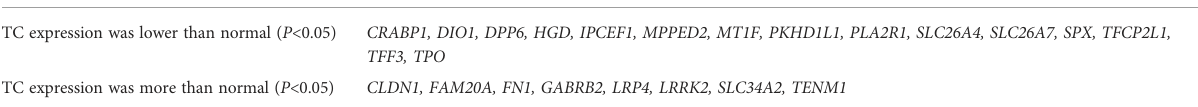
TABLE 1 Twenty-three differentially expressed genes between normal and thyroid cancer (TC) samples. Expression GENE TC expression was lower than normal ( P